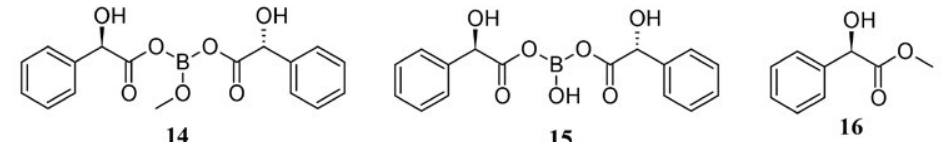
Figure 1. Plausible structures of intermediate during the coupling reaction.